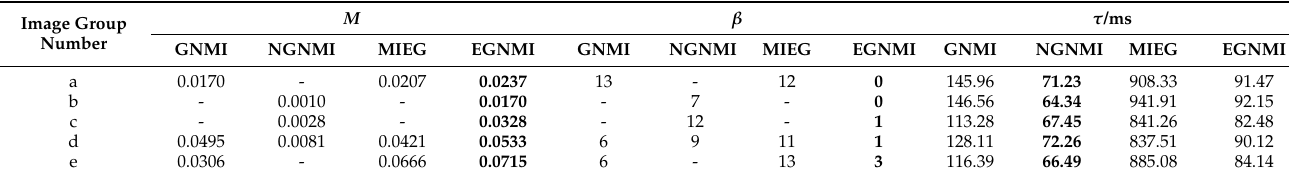
Table 4. Comparison of evaluation functions at different scenes.